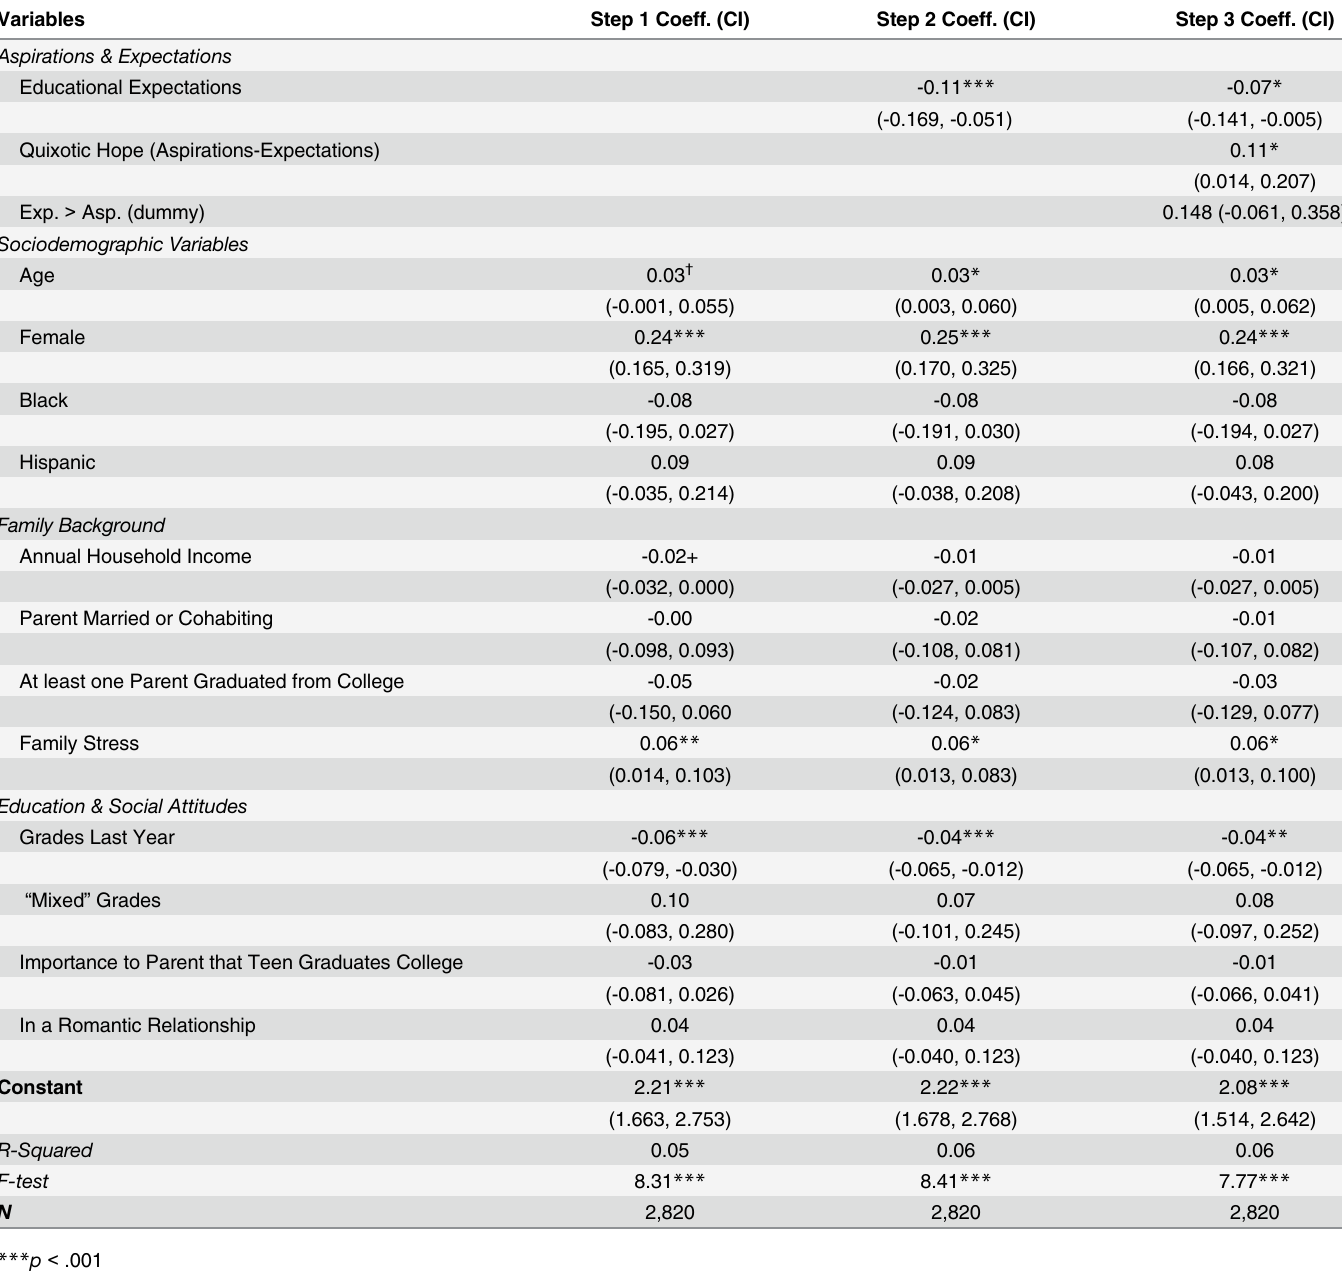
Table 7. Results of regression analyses for Study 2 Time 1